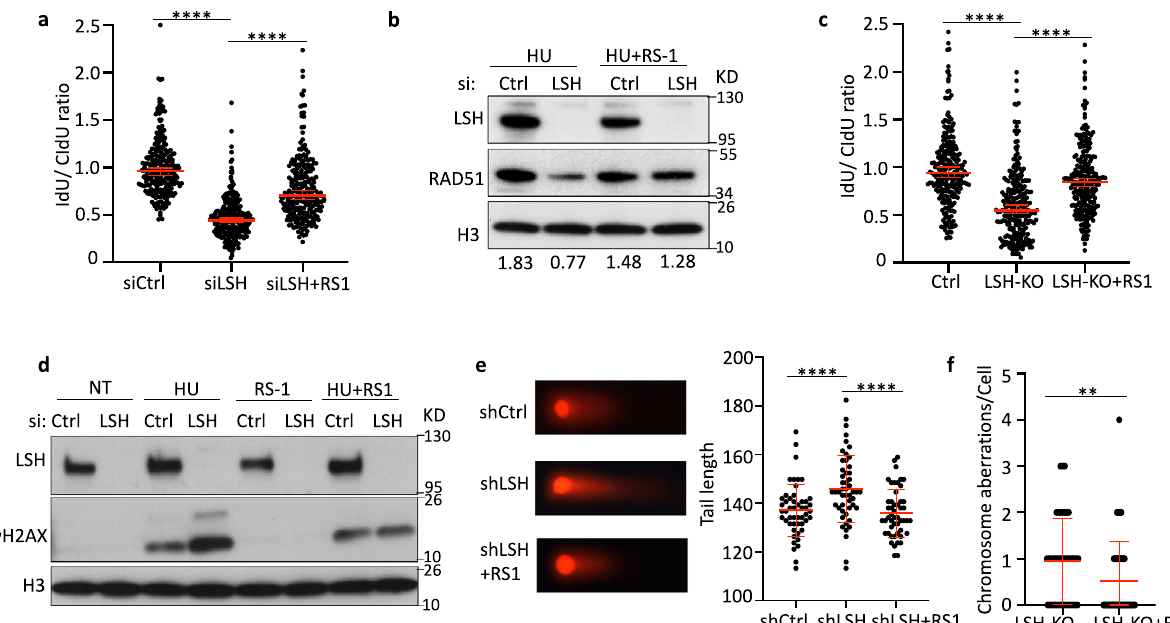
Fig. 5 Recovery of nascent DNA degradation upon RS-1 treatment. a Nascent DNA degradation analysis in U2OS cells transfected with the indicated siRNA after exposure to HU in the presence or absence of 10 µ M RS-1. The IdU/CldU ratio calculations are done as outlined for Fig. 2a. Representative of n = 3 independent experiments. Data are represented as median ± 95% CI ( n = 250 DNA fi bers). **** p < 0.0001 by two-tailed Mann – Whitney test. b Immunoblot analysis of chromatin fractions for the detection of RAD51 protein. U2OS cells were transfected with the indicated siRNA and exposed to 4 mM HU for 5 h in the presence or absence of 10 µ M RS-1. c Nascent DNA degradation analysis in LSH-de fi cient lymphocytes (KO) or control lymphocytes (Ctrl) after exposure to HU in the presence or absence of 10 µ M RS-1. The IdU/CldU ratio calculations are done as outlined for Fig. 2a. Representative of n = 3 biologically independent experiments. Data are represented as median± 95% CI ( n = 250 DNA fi bers). **** p < 0.0001 by two- tailed Mann – Whitney test. d Immunoblot analysis of chromatin fractions for the detection of γ H2AX. U2OS cells transfected with the indicated siRNA were analyzed by immunoblotting after exposure to 2 mM HU for 24 h in the presence or absence of 10 µ M RS-1. e DNA damage was evaluated by neutral comet assay in U2OS cells transfected with the indicated shRNA after exposure to 2 mM HU for 24 h in the presence or absence of 10 µ M RS-1. Left: representative images. Right: A scatter plot of tail length from comet assay. Representative of n = 3 independent experiments. Data are represented as mean ± SD ( n = 50 cells). **** p < 0.0001 by Student ’ s two-tailed t test. f Chromosome aberrations to metaphase chromosome from LPS stimulated LSH- depleted lymphocytes (LSH-KO) in the presence or absence of 10 µ M RS-1 was determined by Giemsa staining. Representative of n = 3 biologically independent experiments. Data are represented as mean ± SD ( n = 54 cells). ** p < 0.01 by Student ’ s two-tailed t